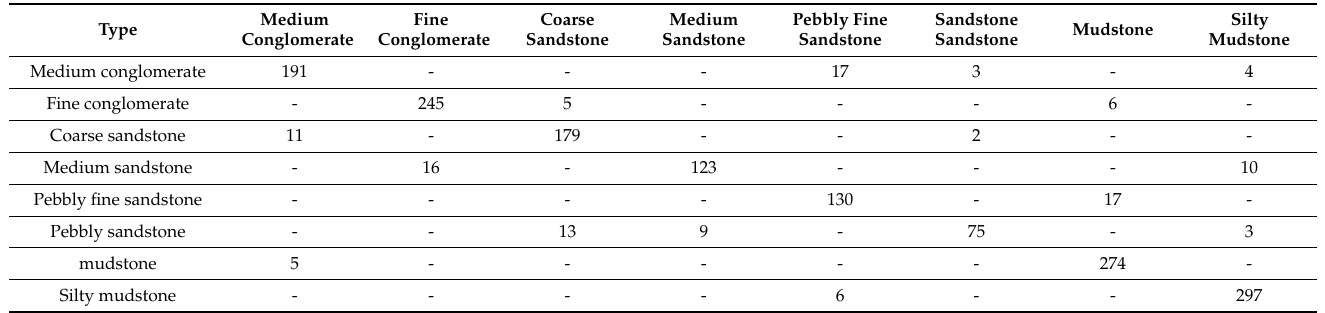
Table 2. Lithology prediction results of MKBoost-MC